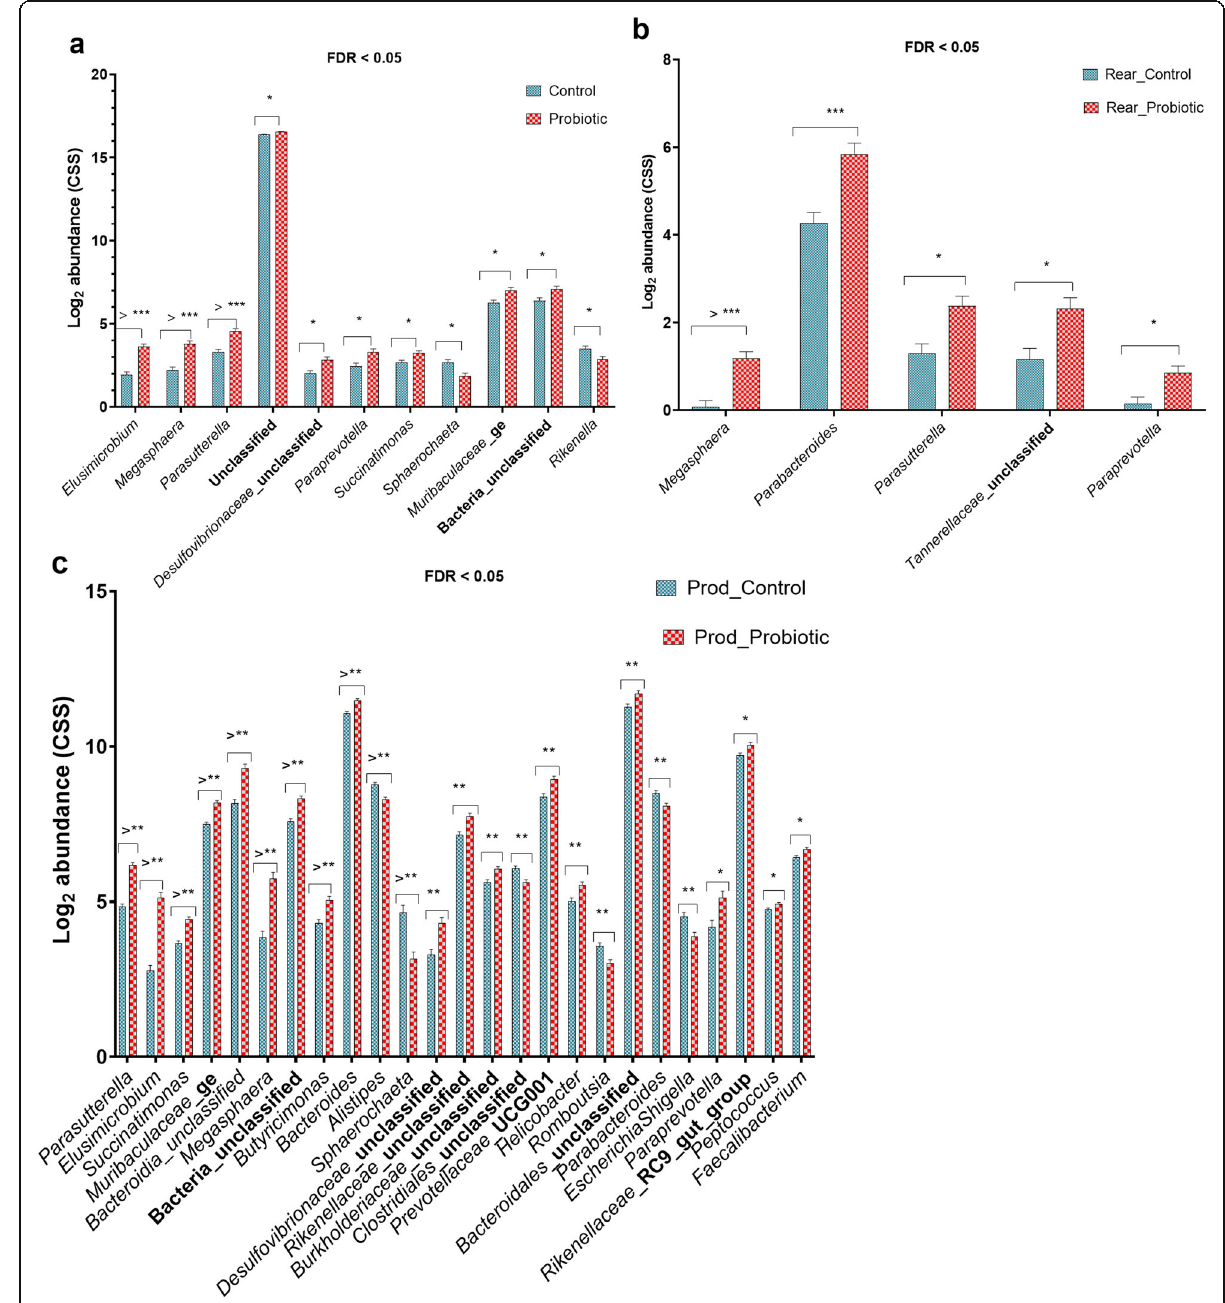
Fig. 3 The abundance of gut microbiota at the genus level is affected by probiotic supplementation. a ). Overall relative abundance levels of microbial communities affected by probiotic. b ). Relative abundance levels of microbial communities in the rearing phase of layer between the control (Rear_Control) and probiotic supplemented (Rear_Probiotic) flocks. c ). Relative abundance levels of microbial communities in the early production phase of layer between the control (Prod_Control) and probiotic supplemented (Prod_Probiotic) flocks. Relative abundance levels (in log 2 cumulative sum scaling) was calculated in Calypso software and the data were visualised in GraphPad Prism v.8.0.0. Asterisks (*, ** and ***) show P values at 0.01, 0.001 and 0.0001,